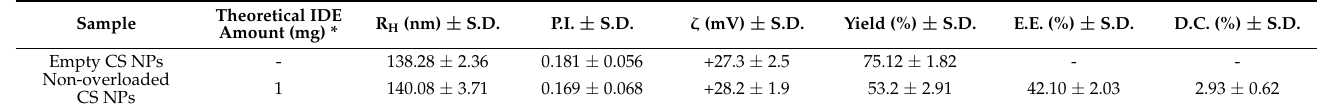
Table 1. Hydrodynamic radius (R H ), polydispersity index (P.I.), zeta potential ( ζ ), Yield (%), encap- sulation efficiency (E.E.) (%), and drug content (D.C.) (%) of CS NPs produced by ionotropic gelation of CS with SBE- β -CD (empty CS NPs) and the IDE/SBE- β -CD inclusion complex (1:2 molar ratio) (non-overloaded CS NPs). The values are expressed as the mean of six batches ± standard deviation (S.D.).